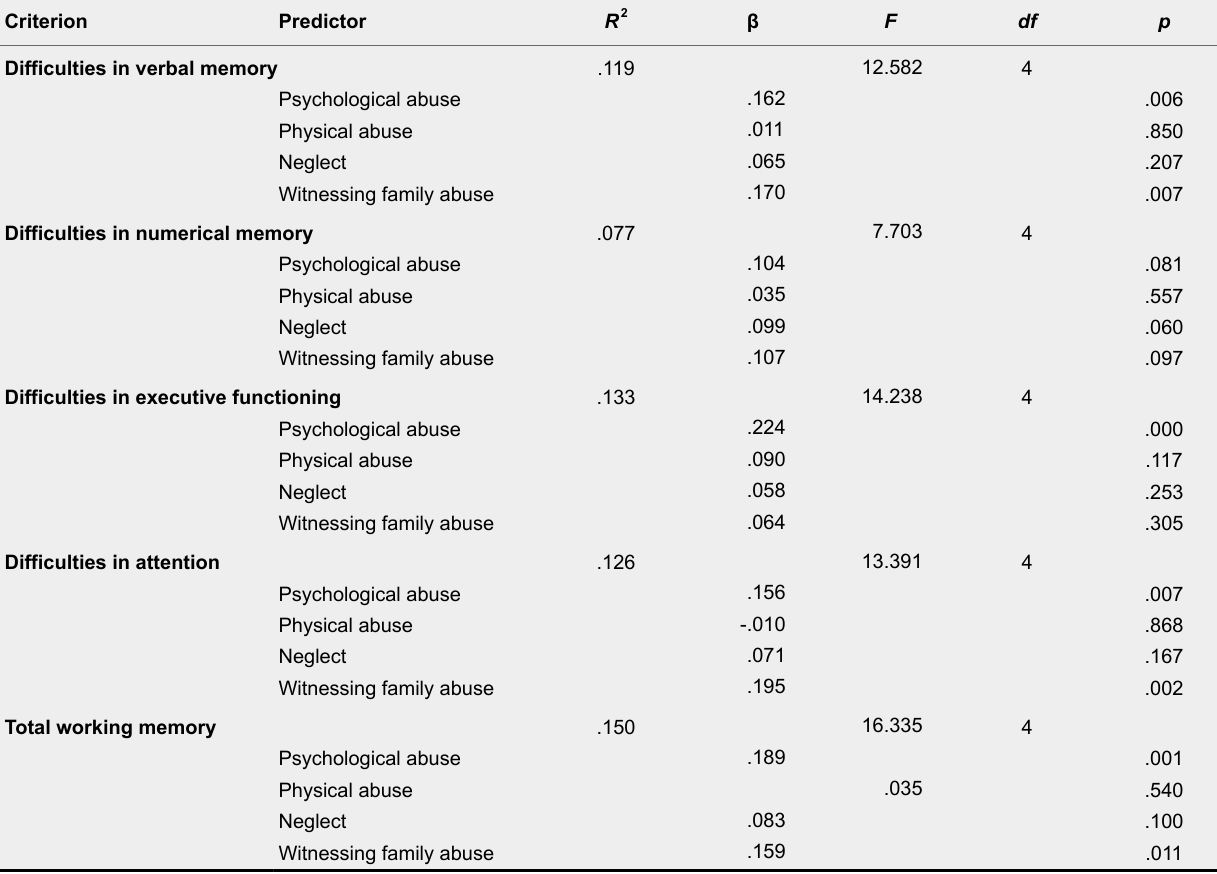
Predictive Value of Various Forms of Maltreatment in Childhood and Neglect for Difficulties in Working Memory Capacity